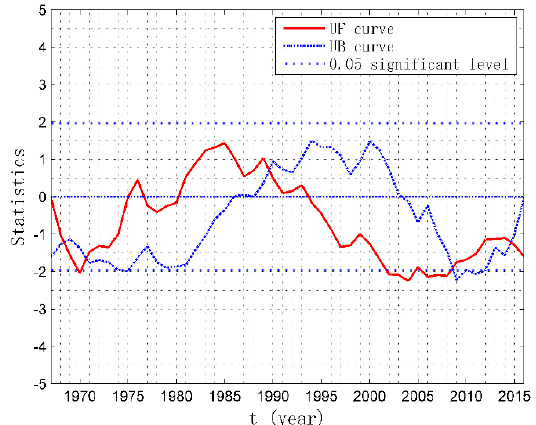
Figure 4. Result of Mann–Kendall mutation analysis in the Tangnaihai station from 1967 − 2016.